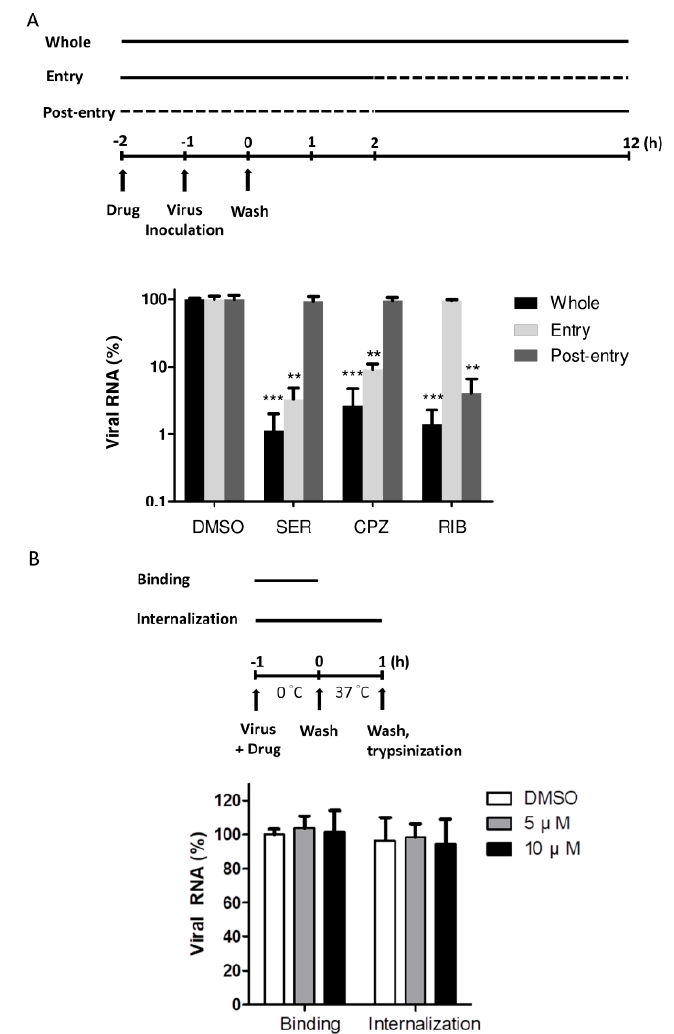
Figure 4. Timing of EV71 inhibition by sertraline. ( A ) Time-of-addition assay with the schematic representation. Each compound was added to RD cells at the indicated times relative to viral infection at an MOI of 0.1 at 37 °C, with the initiation ( − 1 h) and completion (0 h) of viral adsorption indicated. Solid and dashed lines indicate the periods with and without compound treatment, respectively. Whole: − 2 to 12 h; entry: − 2 to 2 h; post-entry: 2–12 h. Sertraline (SER), 10 μ M; chlorpromazine (CPZ), 20 μ M; ribavirin (RIB), 100 μ M. ( B ) The binding and internalization assay with the schematics. EV71 at an MOI of 5 was allowed to bind to the cells on ice for 1 h in the presence of 5 or 10 μ M of sertraline or without drug treatment. For the binding assay, unbound virus was extensively washed off. For the internalization assay, the cells were warmed to 37 °C for 1 h after incubation on ice, allowing viruses to enter cells. Cell surface–bound viruses were removed using trypsin. Quantitative reverse transcription polymerase chain reaction (RT-qPCR) was conducted using total RNA prepared from each condition in ( A ) and ( B ), and shown as relative levels to drug-free control containing 0.05% DMSO. These data were from three independent experiments. ** P < 0.01; *** P < 0.001.